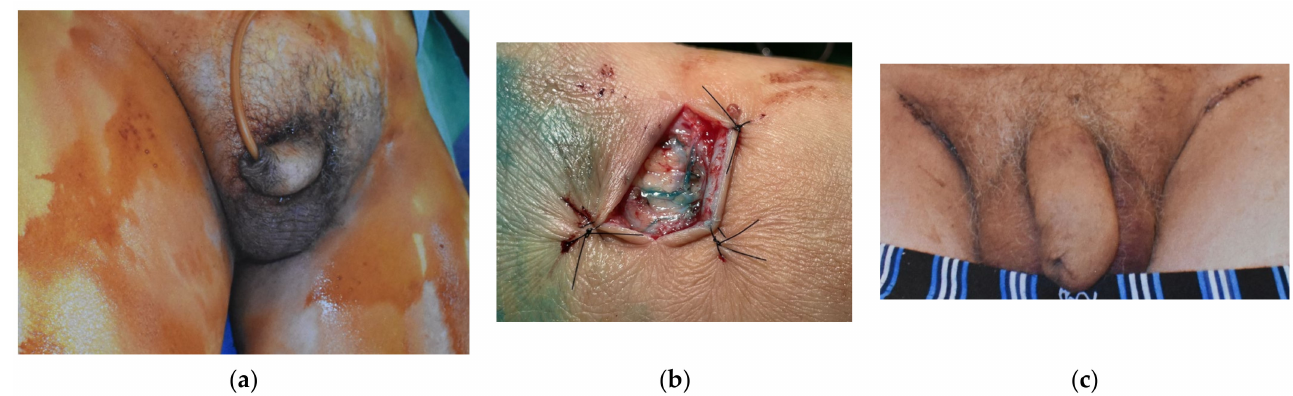
Figure 2. A male patient, 56 years old, presented to our unit with GL stage II involving the scrotal area, subsequent to prostatic cancer treated with prostatectomy, radiation and chemotherapy ( a ) The scrotal lymphedema did not respond to 6 months of CDT, so it was treated with LVA procedure: ( b ) during surgery, ICG was infused near the groin area and the lymphatic ducts were mapped with an ICG camera. Moreover, patent blue was injected to visualize the lymphatic vessels directly. One LVA was performed on each side of the groin area. Three months after surgery ( c ), there was remarkable improvement of swelling at the genital area, and the patient felt more comfortable, with easier passage of urine